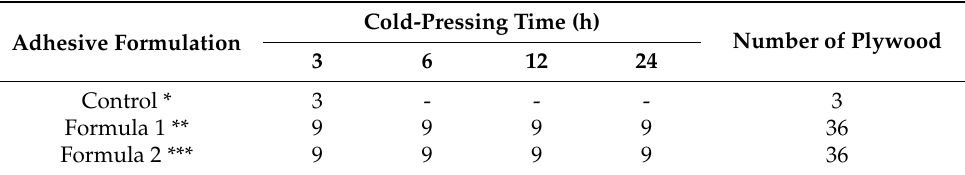
Table 2. Fabrication of plywood bonded with PTH-based adhesive at different adhesive formulations and cold-pressing